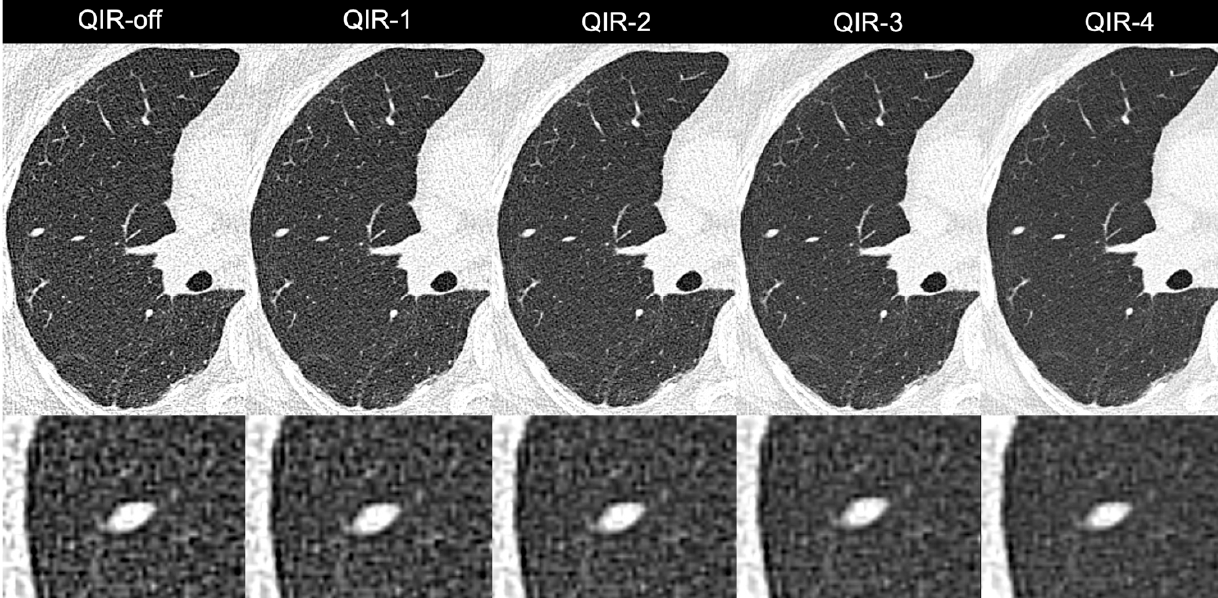
Figure 6. Images of a 58-year-old male patient with a solid 6 mm pulmonary nodule in the lateral middle lobe. Noise was reduced considerably when switching from QIR-off to higher levels of QIR. Note the slightly smoothed appearance of the nodule on QIR-4 as opposed to lower levels of QIR.